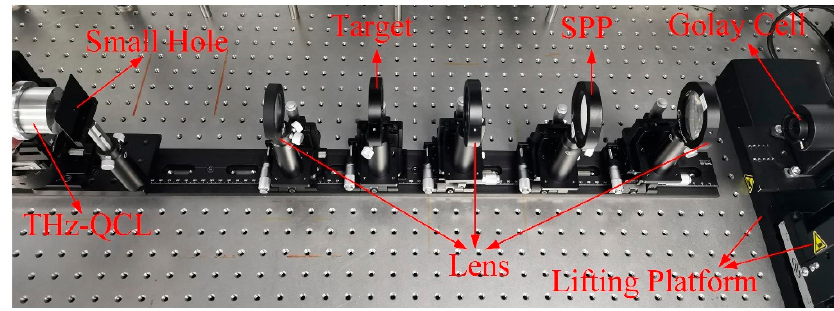
Figure 4. Experimental setup of the THz SSF imaging.